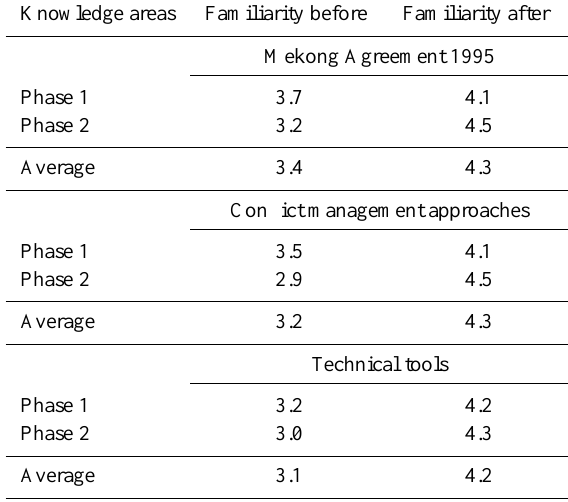
Table 6. Familiarity with three knowledge areas taught in relation to addressing transboundary issues before and after the MRC-FMMP Capacity Building Programme, per years of working experience (n = 37 ) ∗